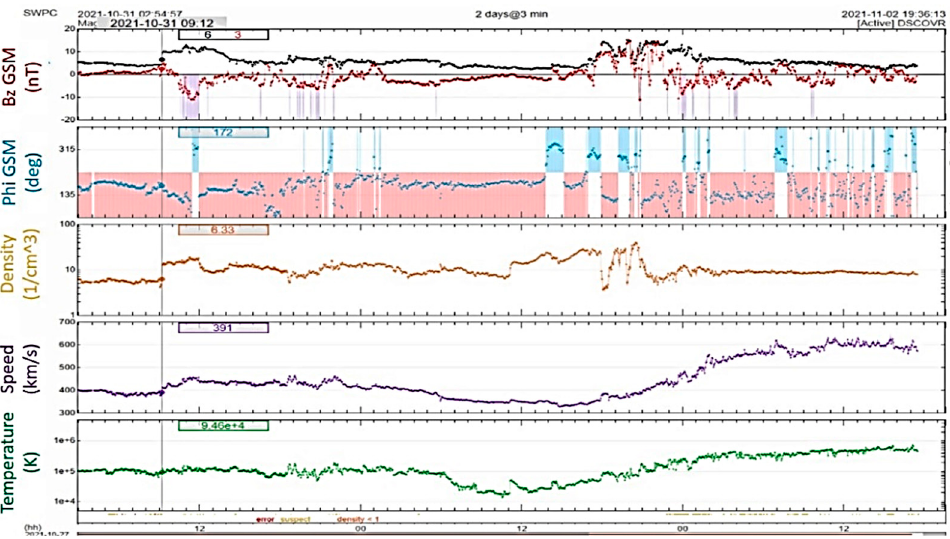
Figure 2. The associated CME with the X1.0 flare finally arrived at the Earth on 31 October at approximately 09:12 UT (vertical grey line). Solar wind and plasma data were provided by DSCOVR spacecraft.